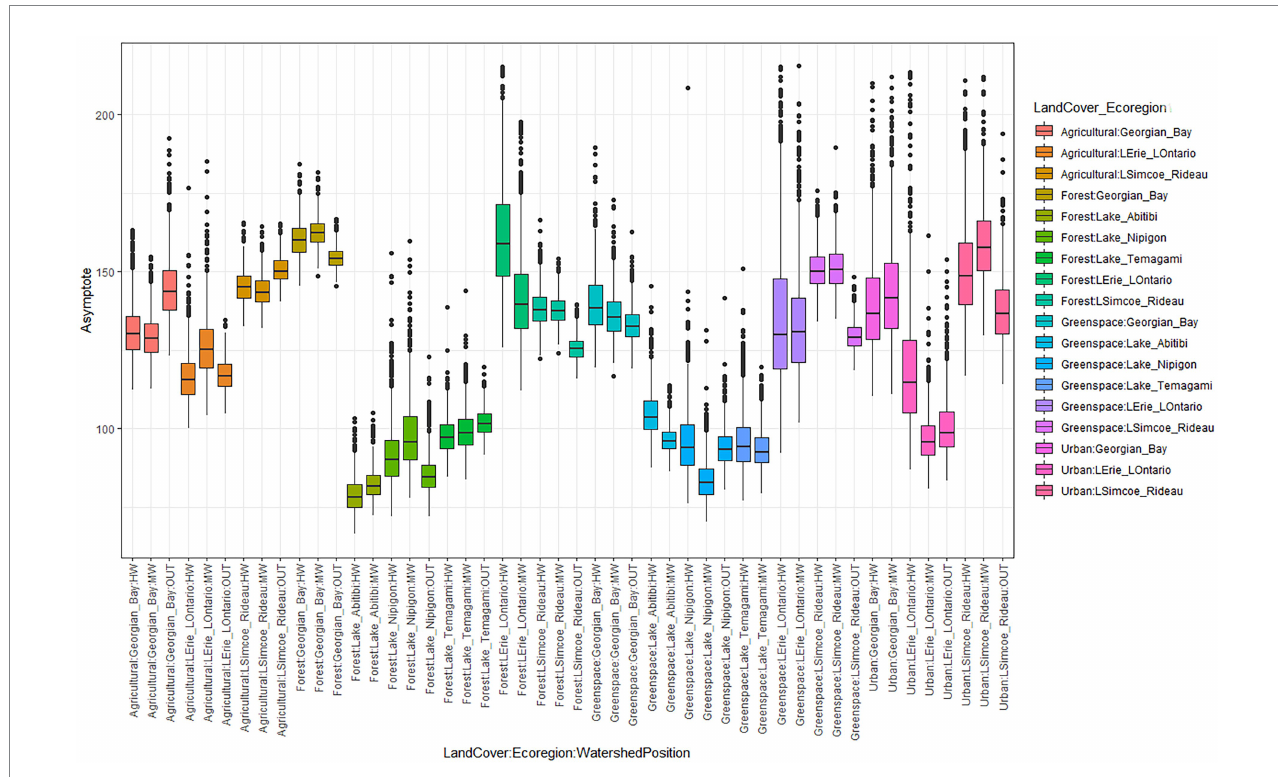
FIGURE 4 Boxplots showing the effect of Ecoregion, land cover type, and watershed position on asymptote.